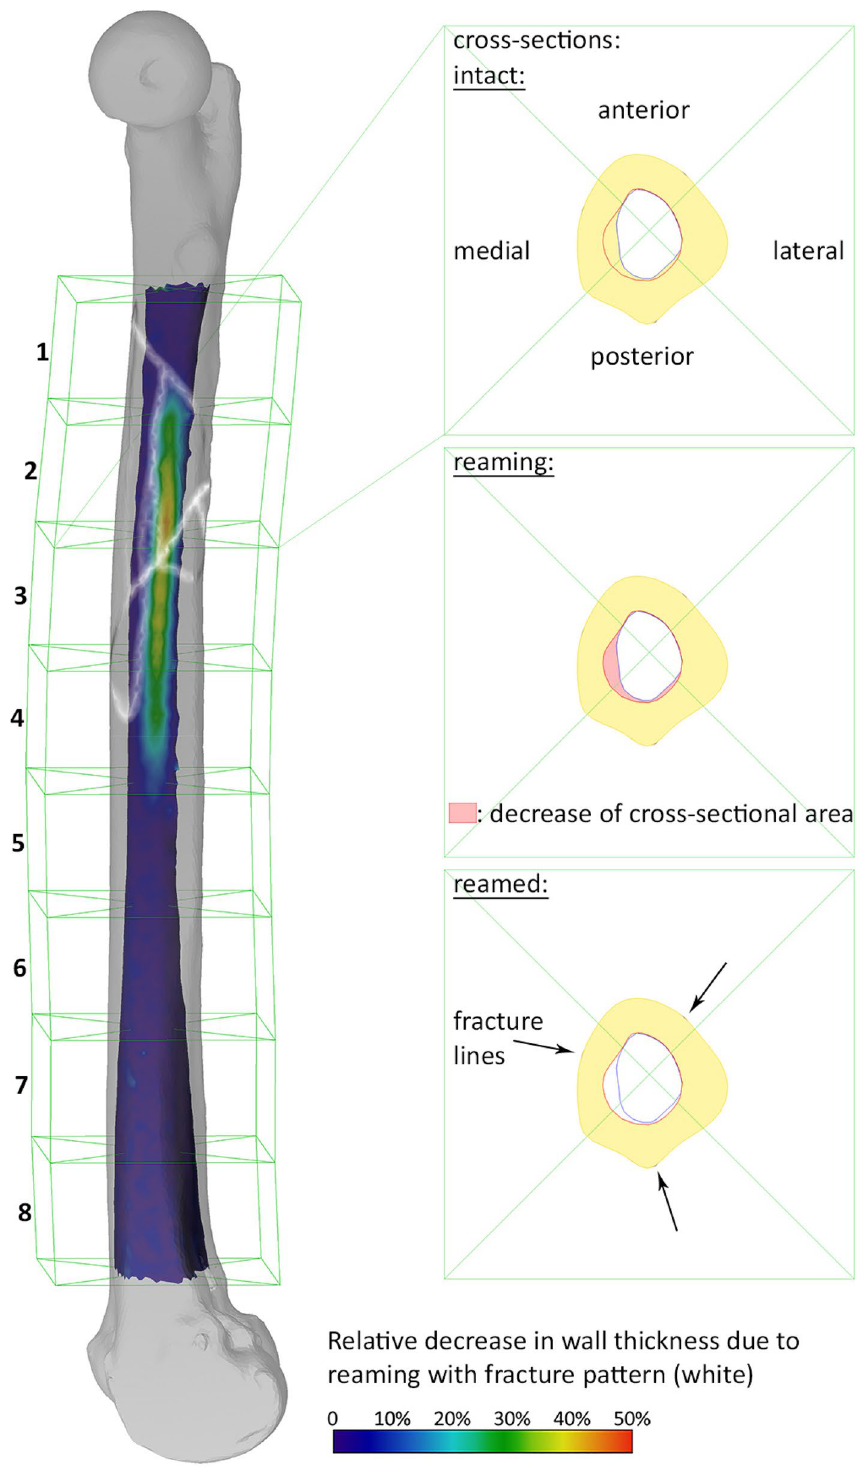
Figure 1. Left: Visualization of the relative decrease in femoral shaft wall thickness post reaming (color-coded) and the fracture pattern (white). The femoral shaft is divided into eighths, and each of those is subdivided into anterior, medial, posterior and lateral quarters (green lines), resulting in 32 regions. Right: Visualization of an exemplary cross-section and the decrease in its cross-sectional area due to